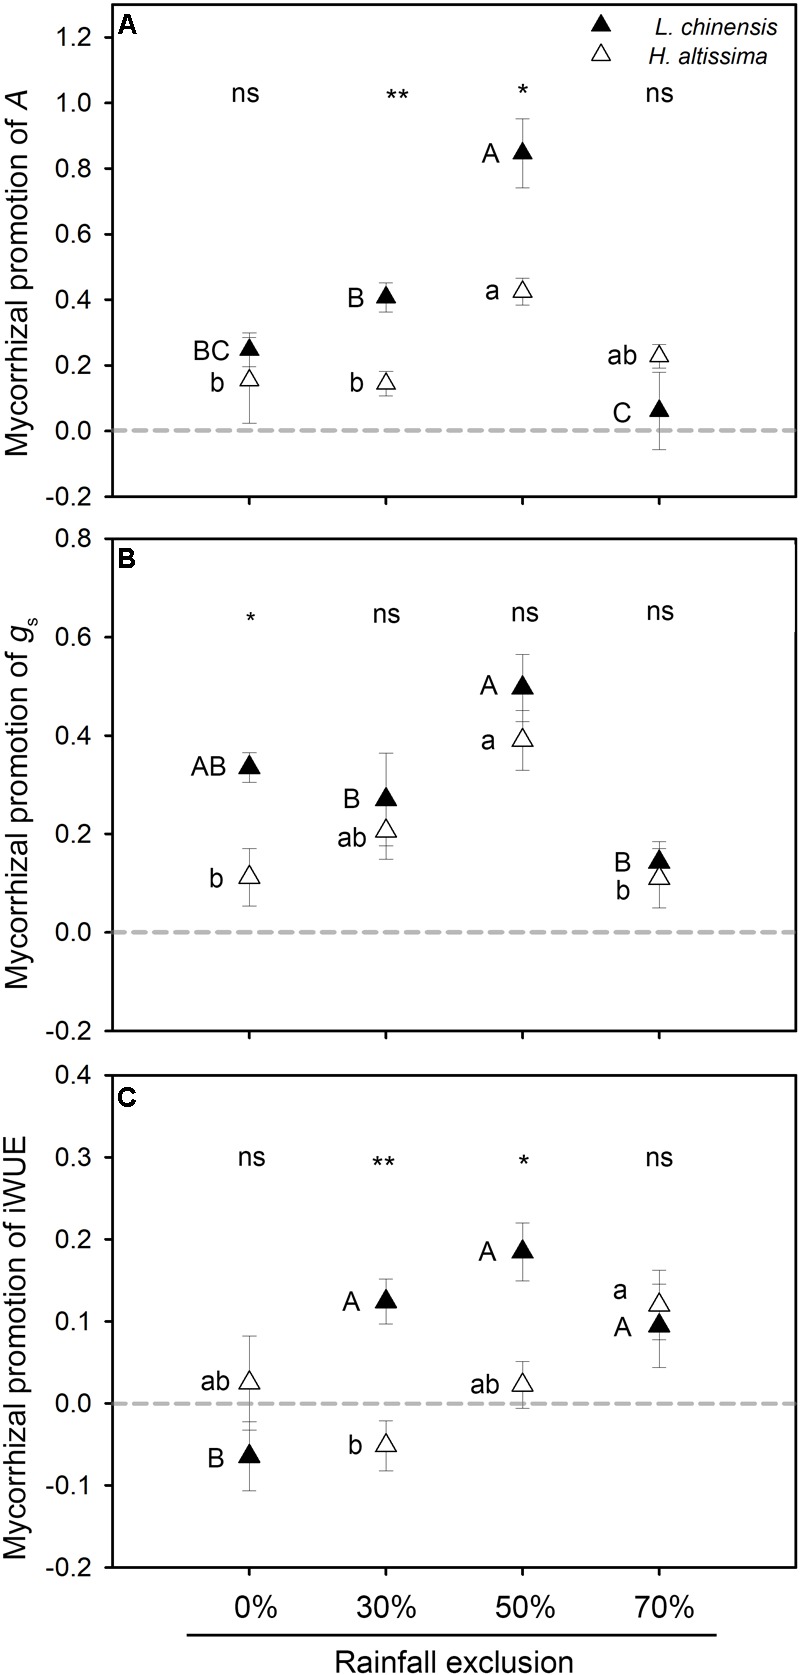
Mycorrhizal response of photosynthesis characteristic, including (A) net assimilation rate (A), (B) stomatal conductance (gs), and (C) intrinsic water use efficiency (iWUE) in L. chinensis and H. altissima. Mycorrhizal benefit existed when values of mycorrhizal response were greater than zero. Different lowercase and capital letters indicate significant differences (P < 0.05) among the rainfall exclusion treatments in L. chinensis and H. altissima, respectively. ∗P < 0.05 and ∗∗P < 0.01 indicates significant differences and ns (P > 0.05) indicates no differences between L. chinensis and H. altissima. Data are reported as mean ± 1 SE (n = 4).